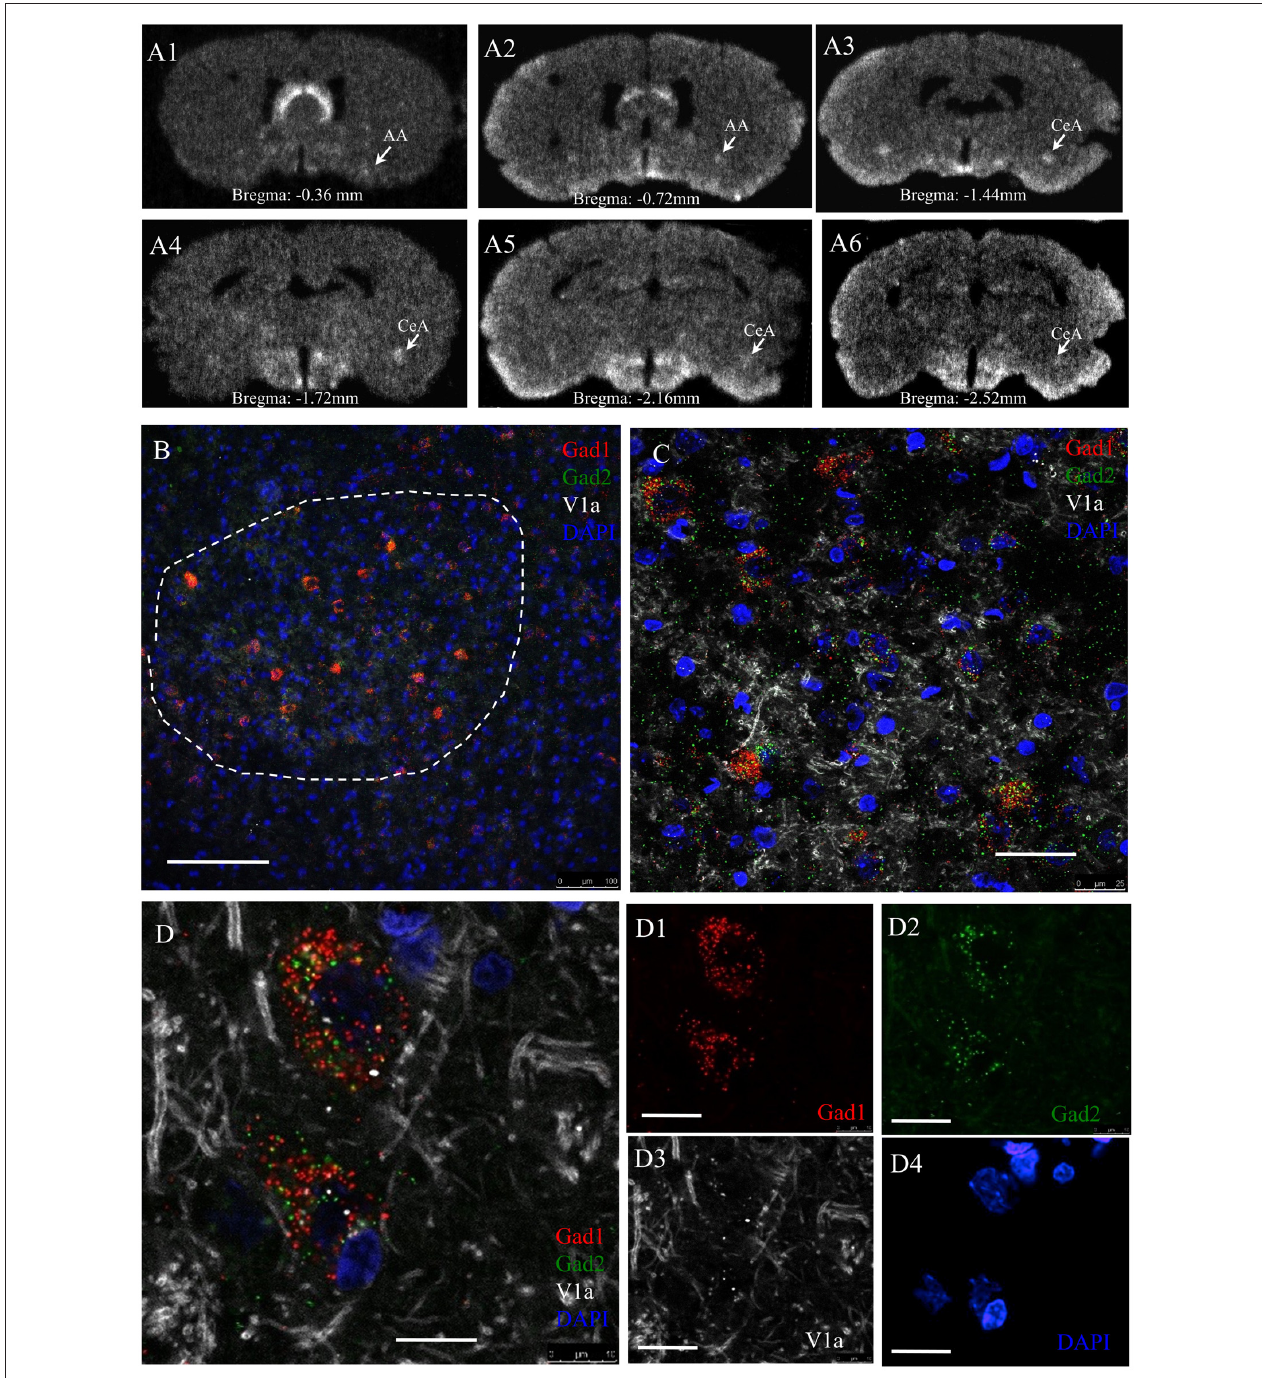
FIGURE 7 | AVP receptor V1a mRNA expression in GABAergic neurons in the CeA. Panel (A’s) sequential coronal sections were hybridized with antisense radioactive AVP V1a riboprobe. Autoradiographs with overnight-exposure were read by phosphorimager. Rostro-caudal coordinates were indicated according to Rat Brain Atlas (Paxinos and Watson, 2006). AA, Anterior amygdala; CeA, central amygdala. (B–D) In situ hybridization using RNAscope-multiplex method targeting the Gad-1, Gad-2 and V1a mRNAs in CeA. V1a mRNA is particularly expressed by Gad-1 and Gad-2 positive neurons. (B) Low magnification showing the selective location of Gad1 + Gad2 expressing cell population in the CeA (dash-line circumscribed region). (C) Further magnifications showing the exclusive expression of V1a mRNA in Gad1 and Gad2 positive cells (100%, n = 98 neurons analyzed). Optical section thickness 1 µ m. (D’s) Confocal 1 µ m optical slice of two cells in CeA expressing Gad1 (red), Gad2 (green) and V1a receptor (white) mRNA. Using the same method for V1b mRNA, we did not find any positive labeling. This data is not shown. The positive control for this latter experiment was done using adenohypophysis tissue. Scale bars: (B) 100 mm; (C) 20 µ m; (D) 10 µ m.